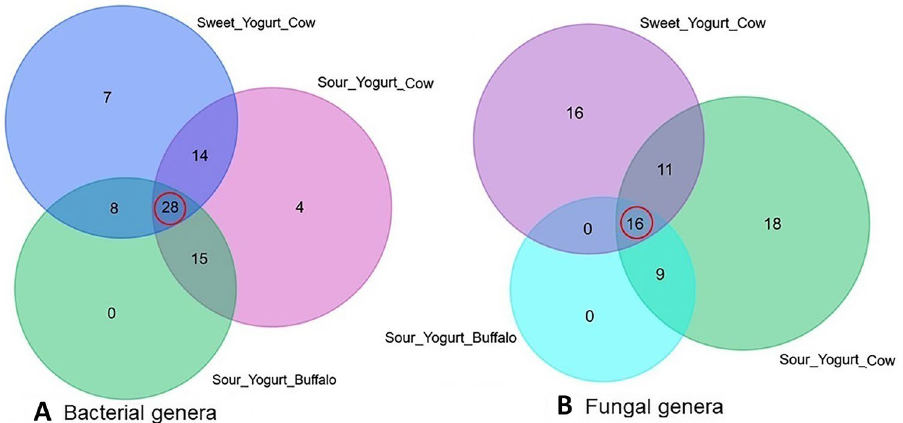
Figure 3. Taxonomic composition of microbiomes in two different tastes (sweet and sour), and milk sources (cow and buffalo) of yogurt samples. ( A ) Venn diagram showing unique and shared bacterial genera in sweet (cow) and sour (cow and buffalo) yogurt. Out of 76 detected genera, only 28 (36.84%) genera (highlighted in red circle) were found to be shared in sweet yogurt cow, sour yogurt cow and sour yogurt buffalo metagenomes. ( B ) Venn diagram comparison of unique and shared fungal genera identified in the study metagenomes. Of the detected fungal genera (n = 70), only 16 (22.86%) genera (highlighted in red circle) were found to be shared in the metagenomes of sweet yogurt cow, sour yogurt cow and sour yogurt buffalo samples. More information on the taxonomic composition and relative abundances is available in Data S1. Venn diagrams were generated through an online tool used for Bioinformatics & Evolutionary Genomics (http:// bioin forma tics. psb. ugent. be/ webto ols/